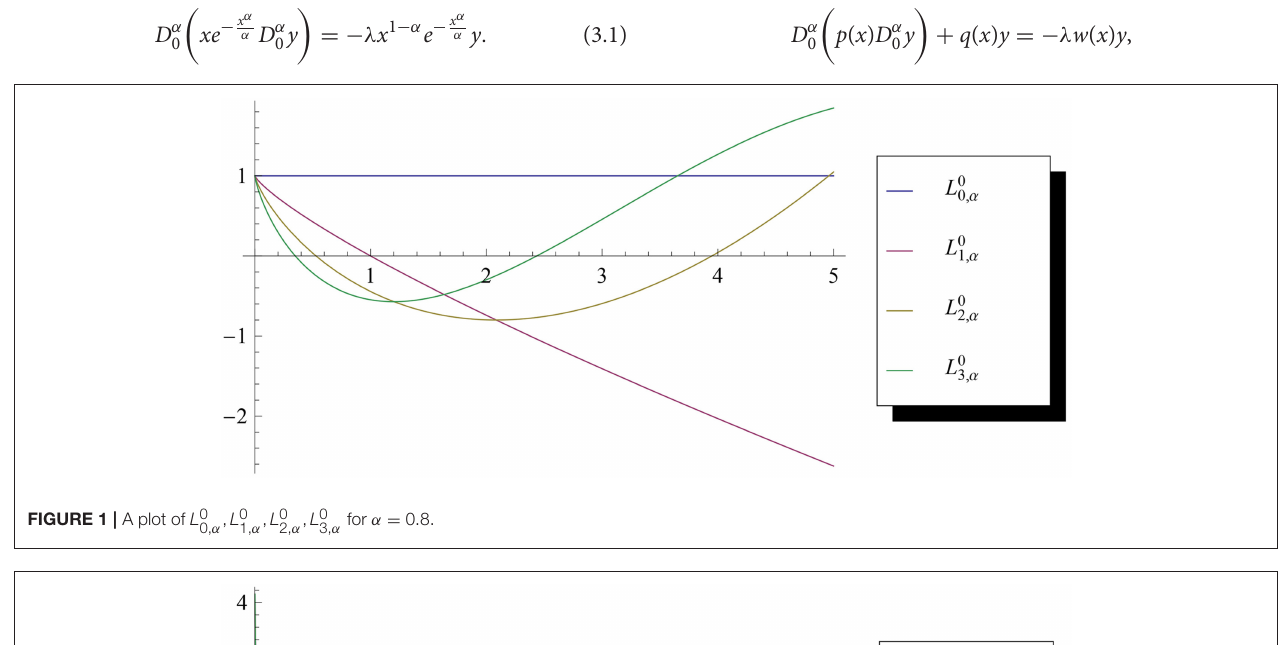
FIGURE 1 | A plot of L 0 0, α , L 0 1, α , L 0 2, α , L 0 3, α for α = 0.8.